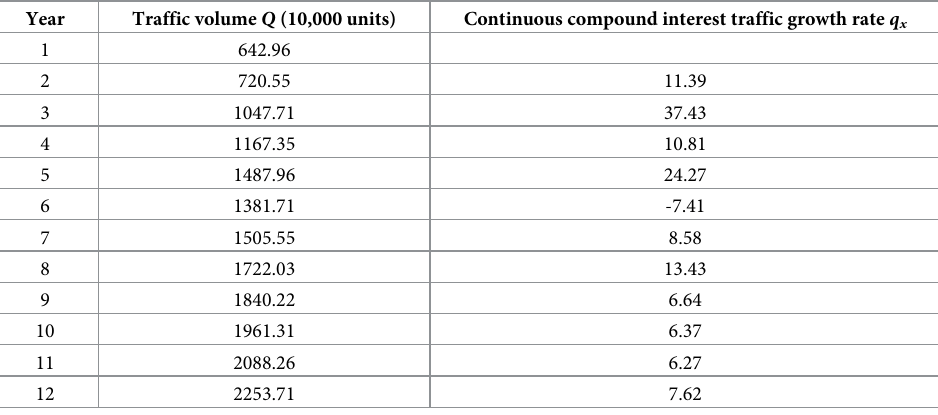
Table 2. 12-year actual data for similar projects.